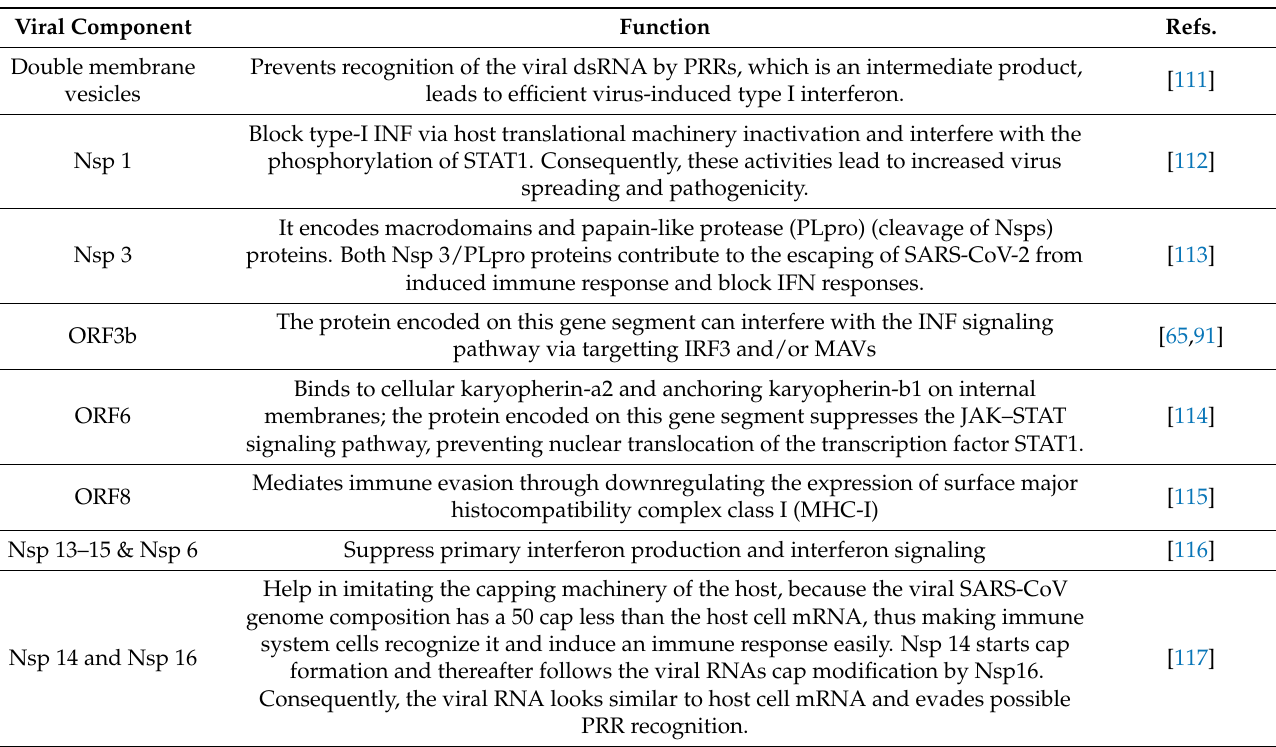
Table 3. SARS-CoV-2 mediated immune-evasion